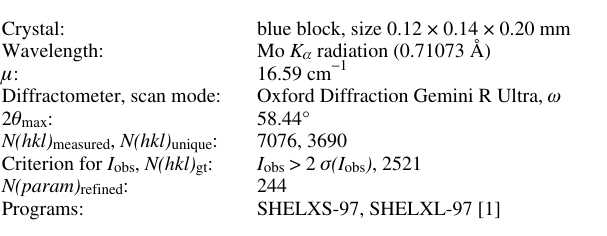
Table 1. Data collection and handling.